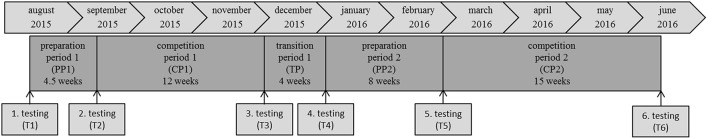
Longitudinal study design. This figure illustrates test sessions over the course of a soccer season.